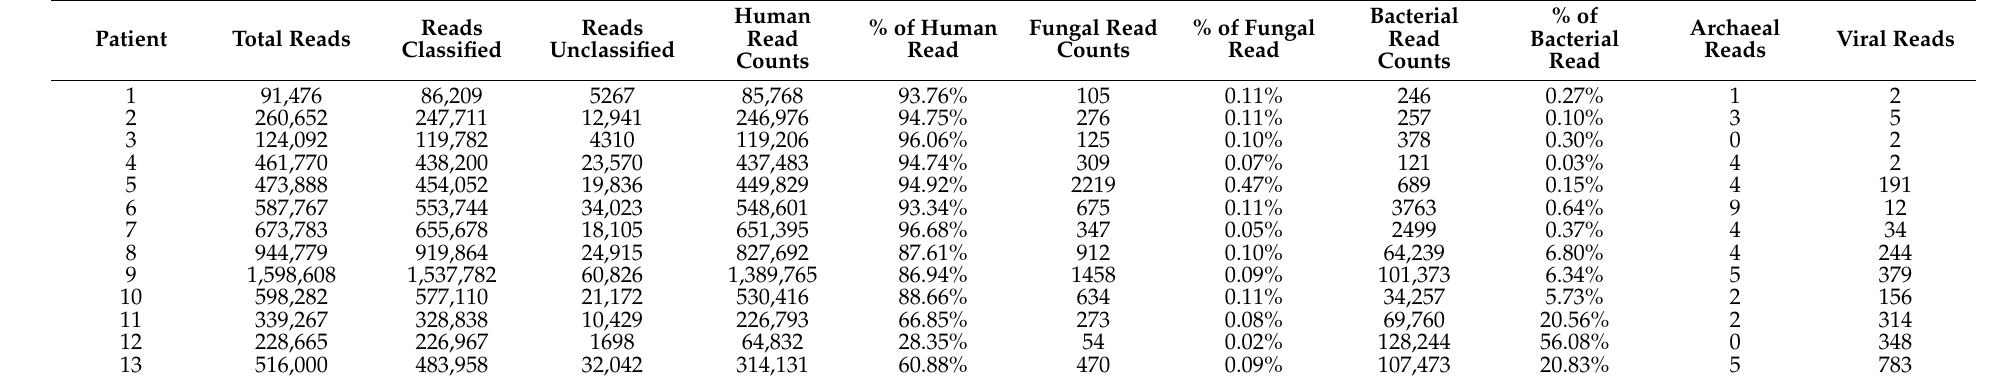
Table 2. Summary nanopore output total sequence reads and percentage of species form the nasal irrigant in patients of chronic